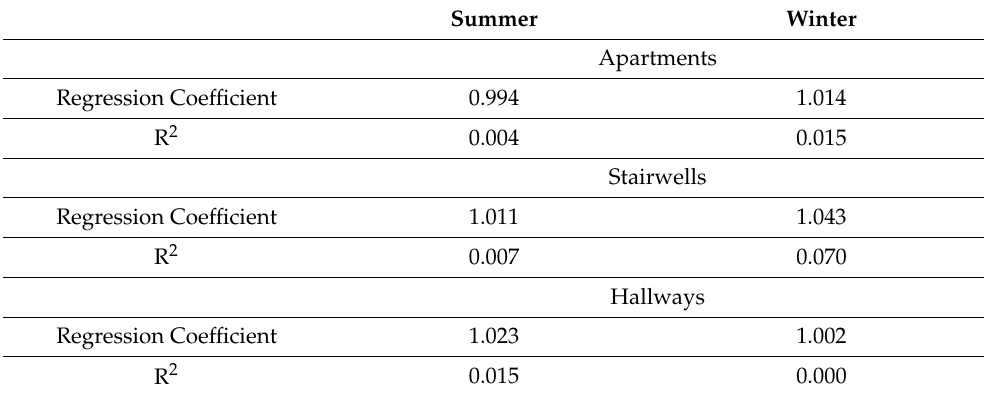
Table 2. Sensitivity Analysis Based on Coefficient of